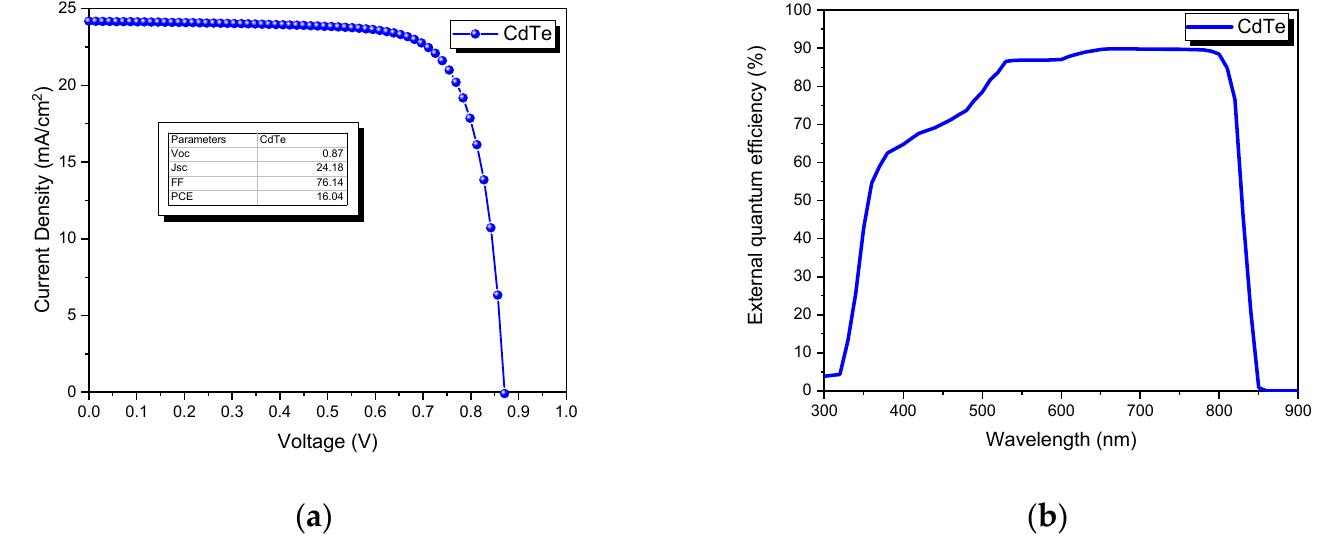
Figure 2. Base solar cell (C/CdTe/CdS/SnO 2 ): ( a ) J-V curve, ( b ) the external quantum efficiency.